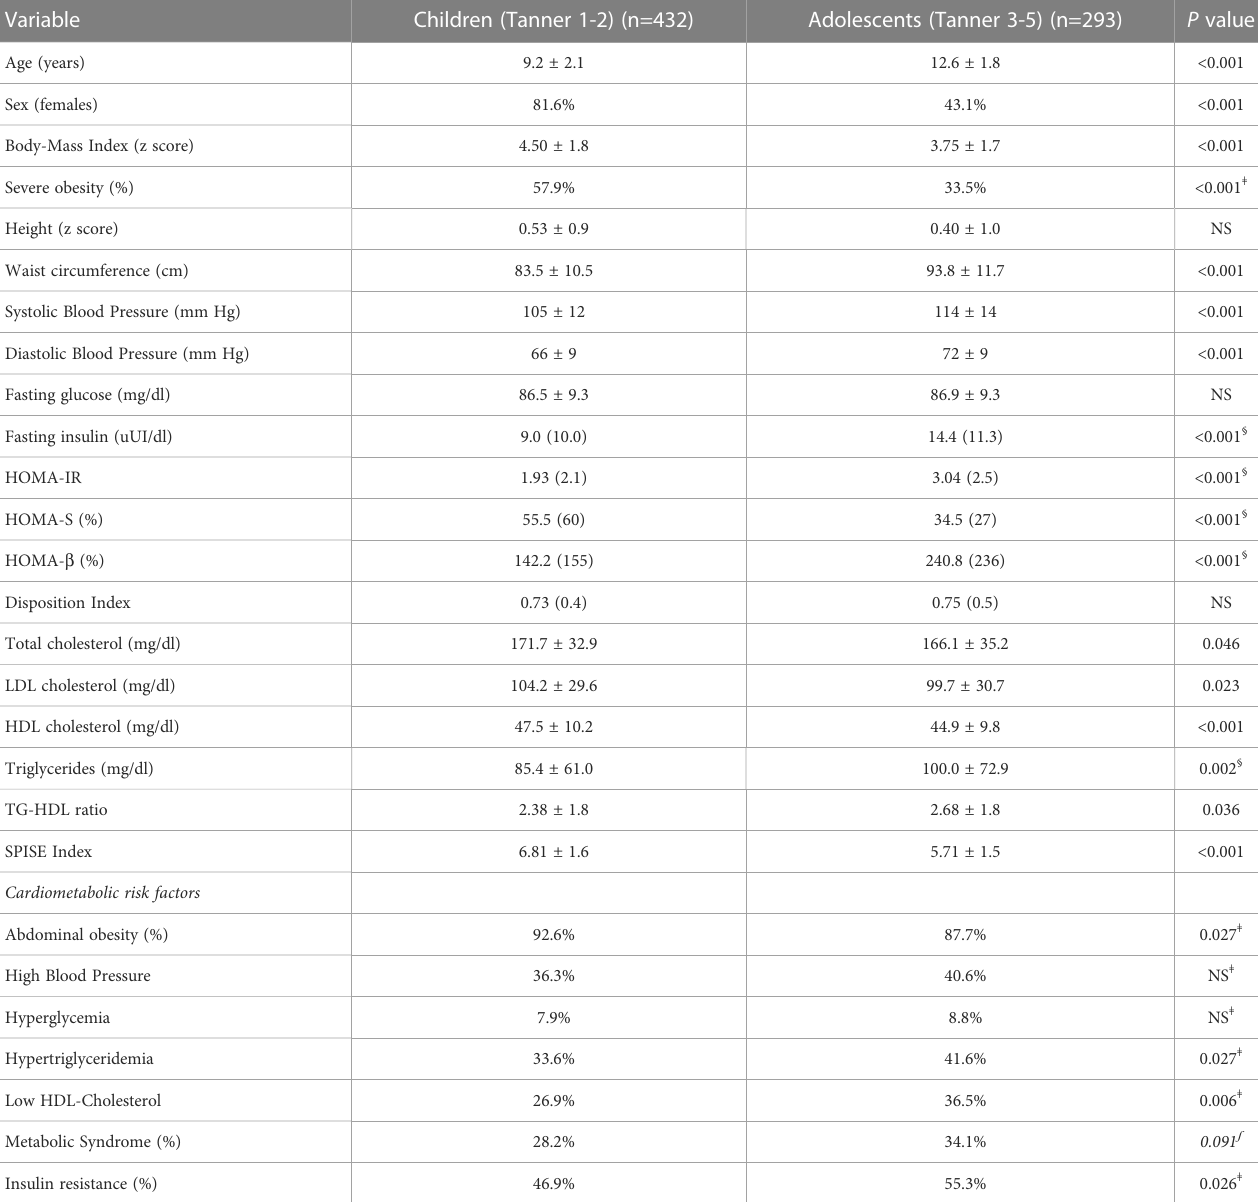
TABLE 1 Anthropometric characteristics and cardiometabolic pro fi le in children and adolescents with obesity (n=725).